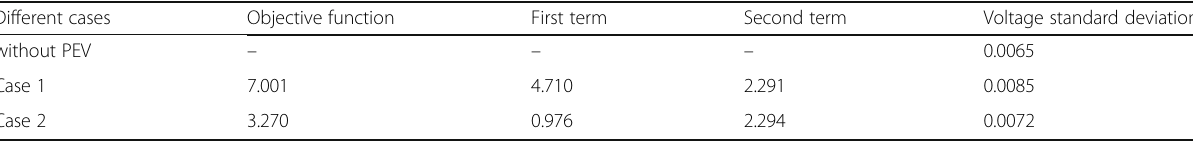
Table 3 The numerical results of two evaluated cases Different cases Objective function First